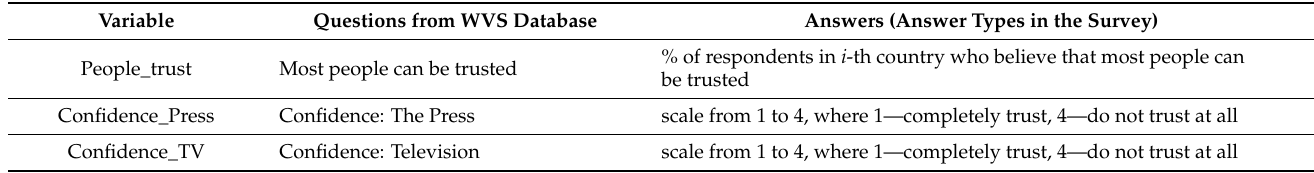
Table 2. List of variables characterizing the attitude towards science in society.